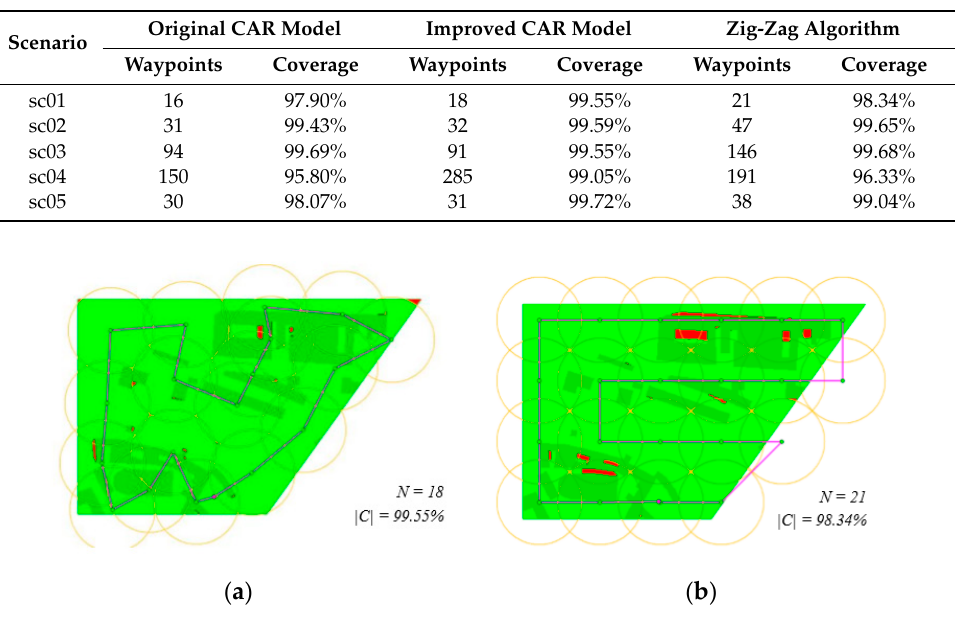
Figure 7. Scenario sc01 when monitoring is enabled during a flight: ( a ) solution by the improved CAR model; ( b ) solution by the zig-zag algorithm.